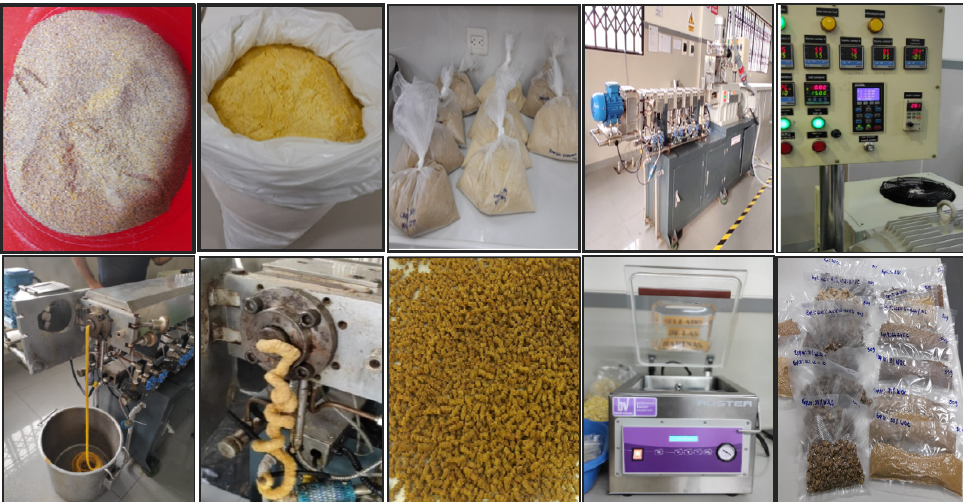
Figure 1. Extruded production workflow. From left to right: At the top—weighing and blending of raw materials; setting up of operation parameters; flour blends feeding and water conditioning. At the bottom—extrusion and cutting of the extrudate into pieces; cooling and storage of the extrudate in bioriented polypropylene bags.